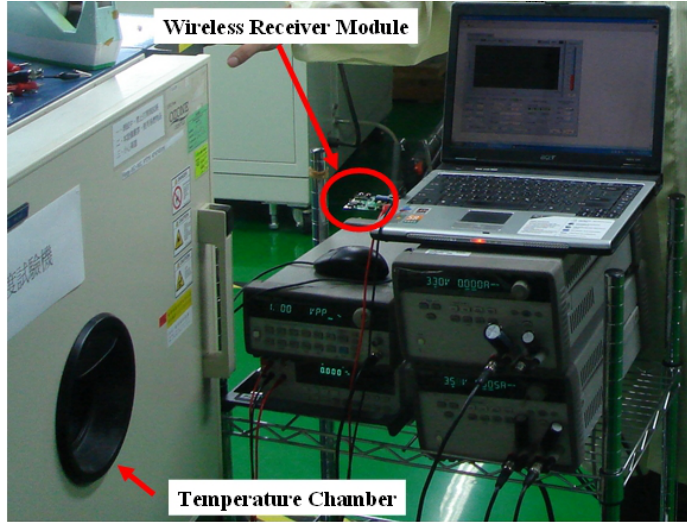
Figure 12. The experiment setup for temperature test on the packaged temperature sensor.